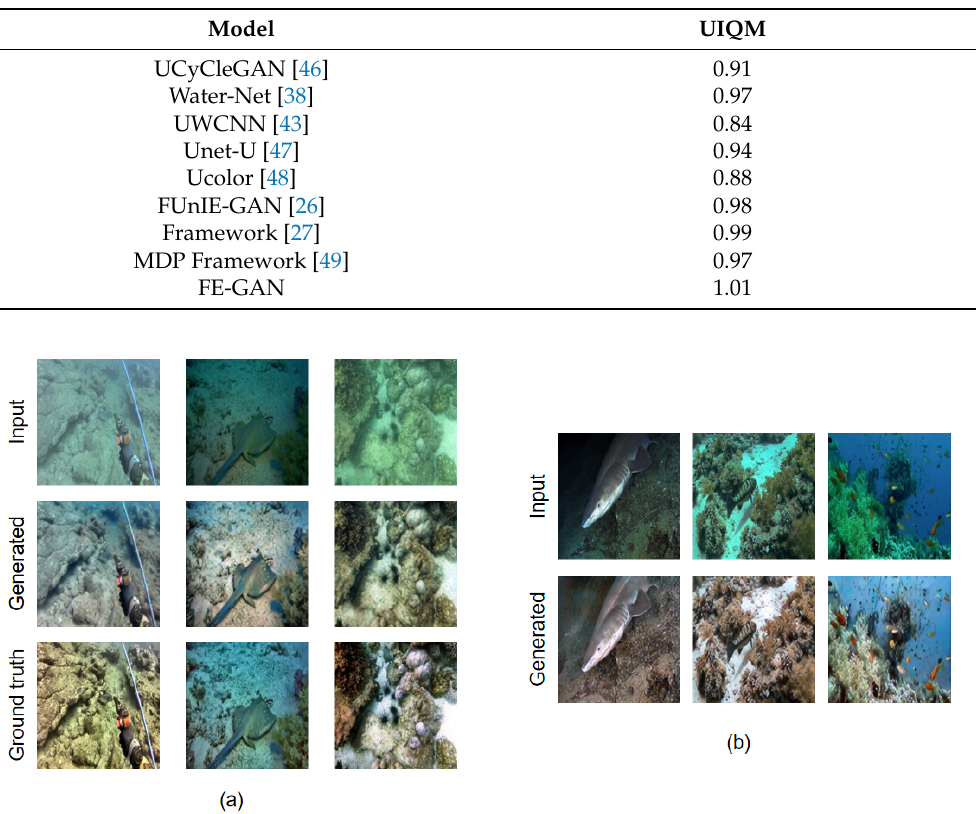
Table 4. UIQM test results of Test-C60. FE-GAN achieved the highest value.